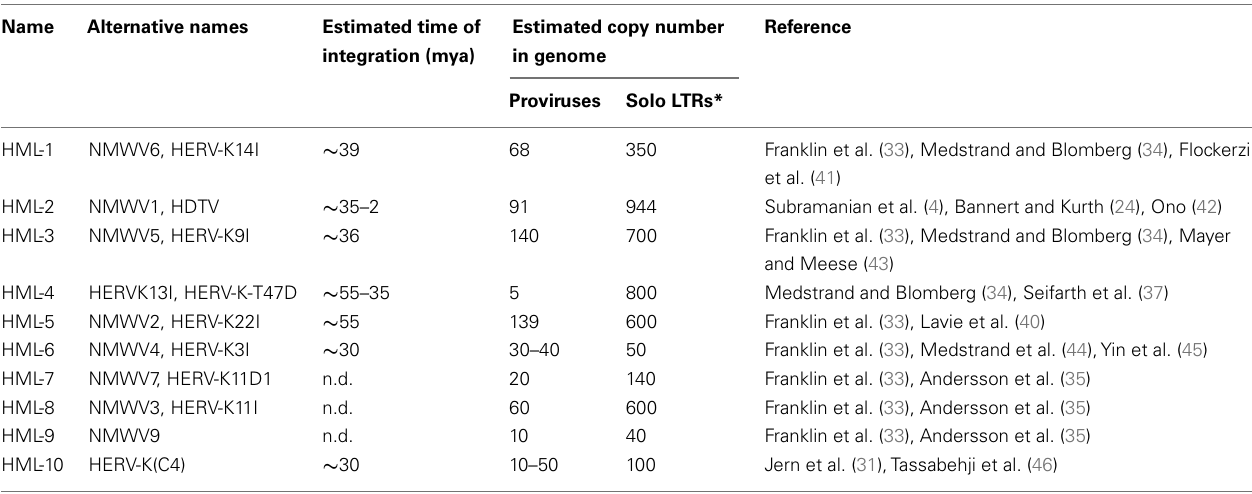
Table 1 | Class II/HERV-K (human MMTV-like)